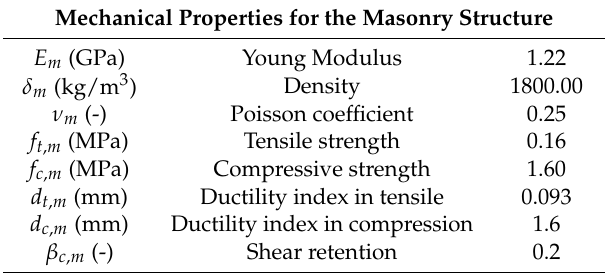
Table 3. Mechanical properties adopted for the macromodelling of the masonry.